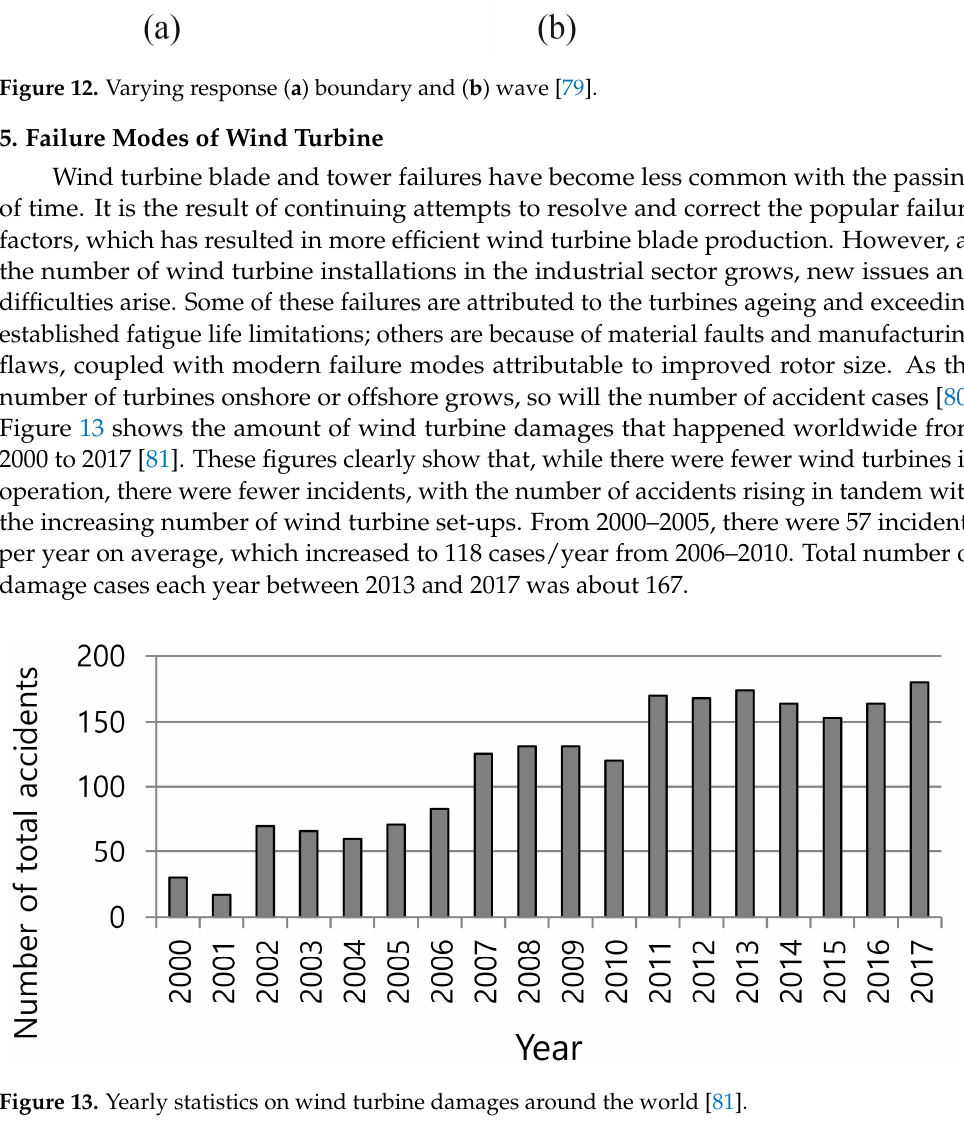
Figure 12. Varying response ( a ) boundary and ( b ) wave [79].